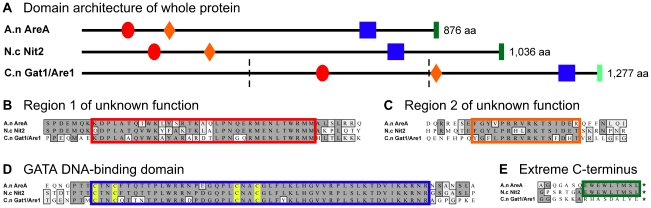
Representative domain architecture and domain sequences of A. nidulans AreA, N. crassa Nit2 and C. neoformans Gat1/Are1.(A) The two conserved regions of unknown function are represented by red ovals and orange diamonds, while the GATA DNA-binding domain is represented by blue squares. The extreme C-terminus domain of AreA and Nit2 (dark green rectangles) is highly conserved but that of Gat1/Are1 has diverged (light green rectangle). Amino acid sequences of all four domains are shown in (B, C, D and E). In addition, the Gat1/Are1 domain architecture is marked with dotted lines to indicate the boundary of the Gat1/Are1 fragments that were tested for protein-protein interaction with Tar1 (see yeast two-hybrid assay section). The universally conserved cysteines involved in zinc ion chelation of the zinc finger are highlighted in yellow.